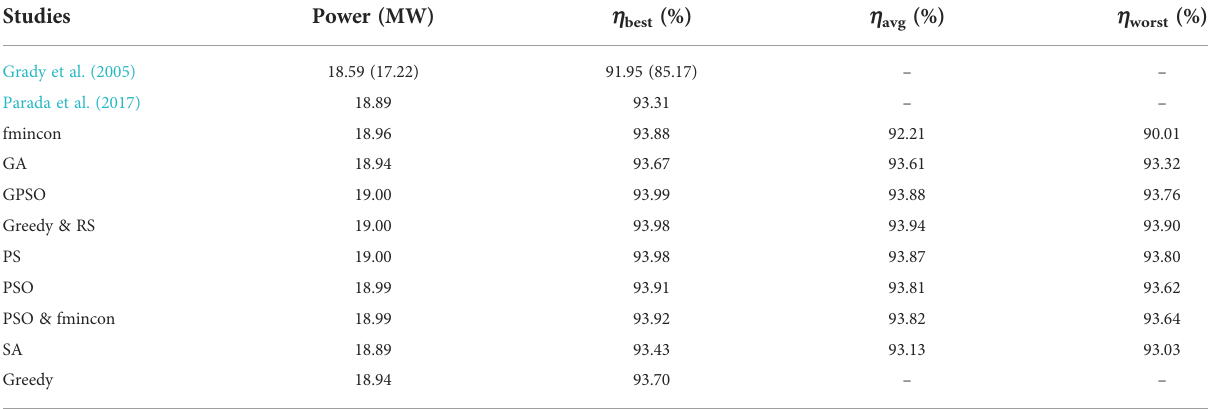
TABLE 3 Comparison of global best solutions of different algorithms. Studies